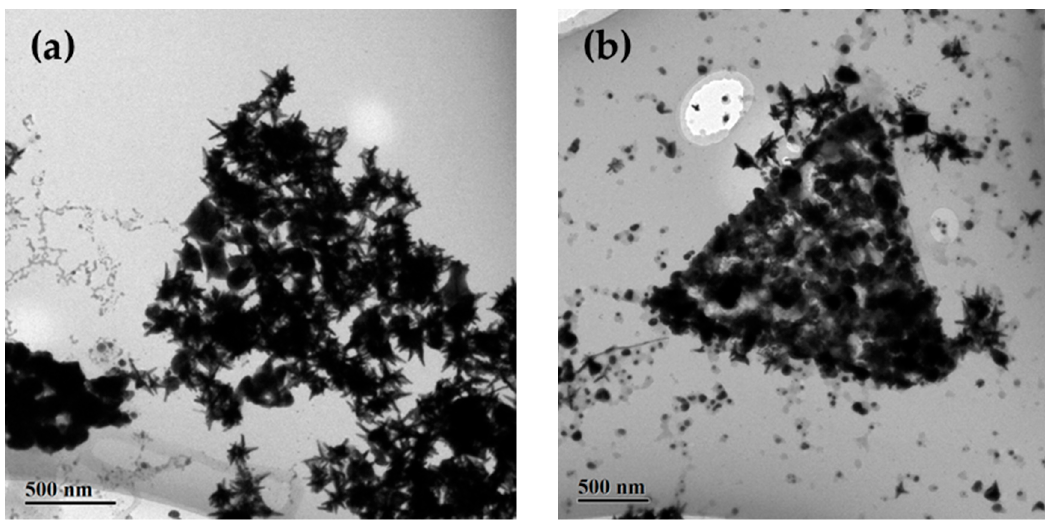
Figure 3. Initial formation of trigonal nanoplates of Ag@AuCu with a low concentration of AgNO 3 (50 µ L). ( a ) Embryonic form of a self-assembled Ag@AuCu trigonal nanoplate. ( b ) Initial formation of a trigonal nanoplate with a clear boundary. The average side length is 2.12 ± 0.04 μ m.